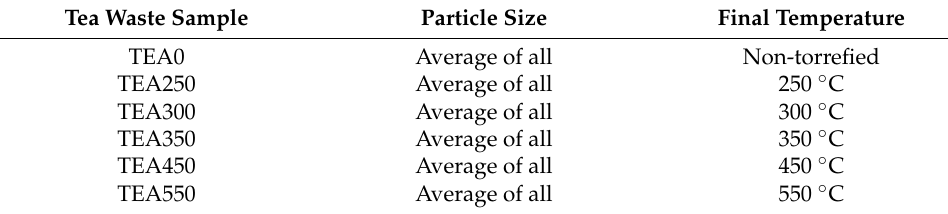
Table 2. List of samples by torrefaction